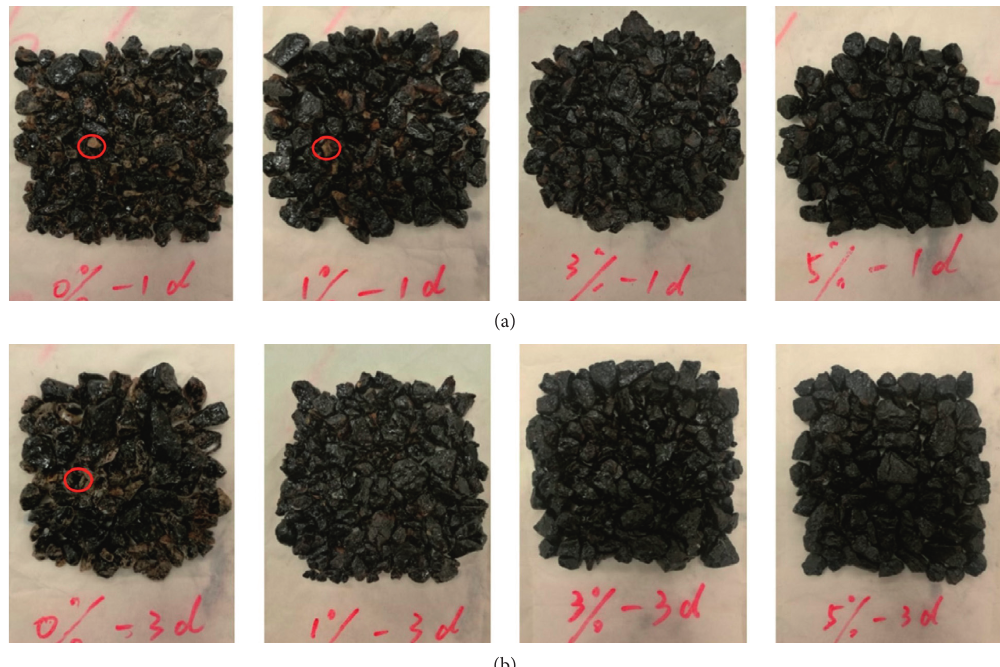
Figure 34: EAM after 10 min boiling (red circles � stripped aggregates) [90]: (a) 1-day bitumen emulsion mixture (from left to right: WEA- 0, WEA-1, WEA-3, and WEA-5); (b) 3-day bitumen emulsion mixture (from left to right: WEA-0, WEA-1, WEA-3, and WEA-5). Note: WEA-1, -3, -5 � weight of epoxy and waterborne curing agents.